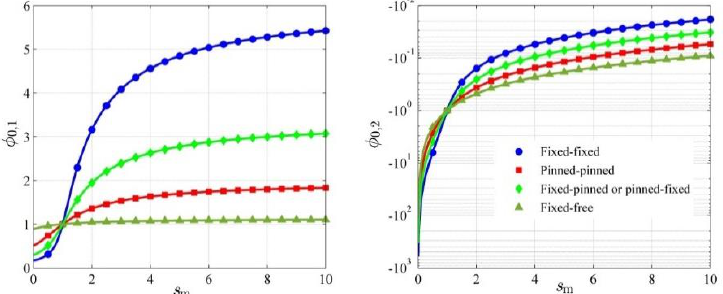
Figure 8. Mode amplitude ratios in two sub-modes corresponding to the 1st basic mode versus contact stiffness ratio for different boundary conditions when 𝑠 e = 100 and 𝑠 k = 1 .